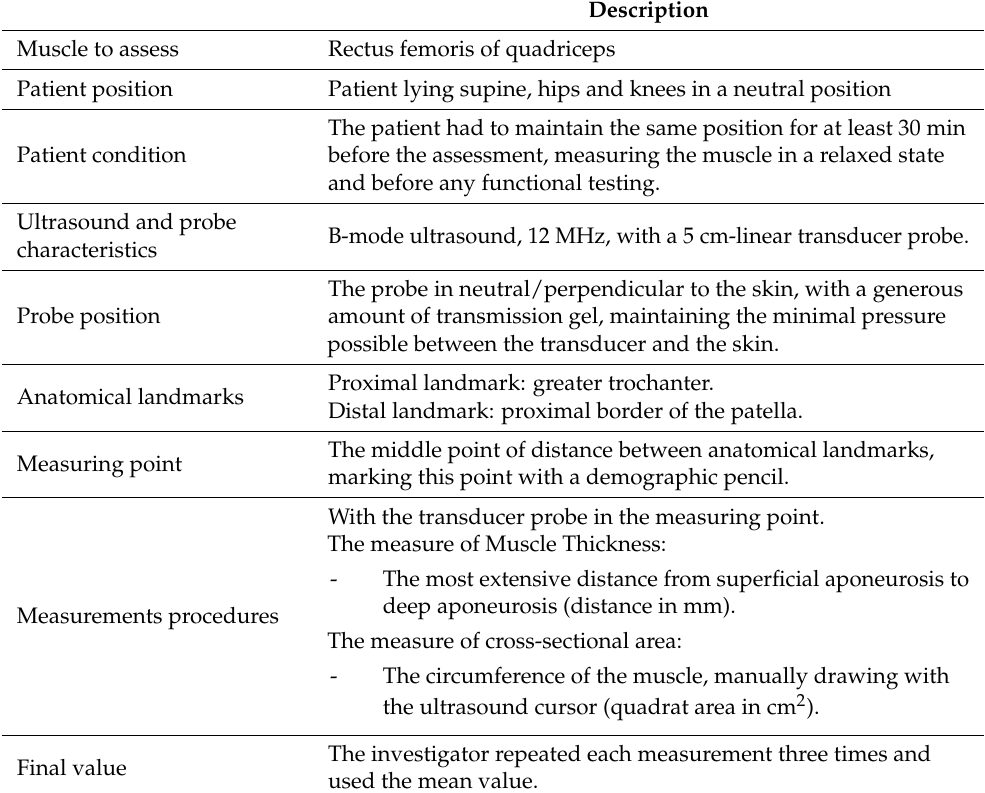
Table 1. The protocol of Muscle Thickness and Cross-Sectional area of rectus femoris measure using musculoskeletal